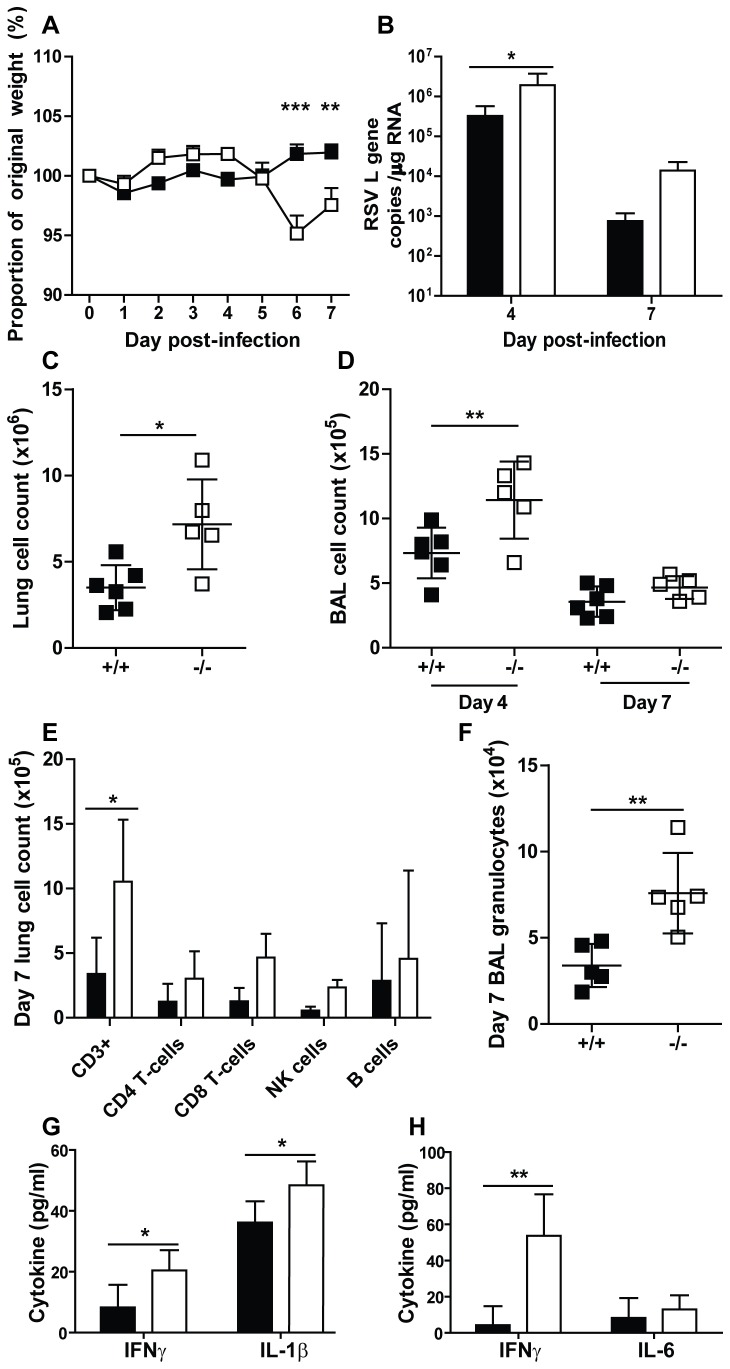
Comparison of RSV infection in Ifitm3-/- mice to wild type mice.Ifitm3-/- or wild type littermate control mice were infected i.n. with 5x105 RSV A2. Mice were weighed daily and weight changes recorded as a percentage of original weight (A). Lungs were excised and viral load calculated by qPCR on days 4 and 7 pi (B). Total cell counts from lung (C) and BAL (D) were calculated, along with totals of CD3, CD4 and CD8 (T cells), CD19 (B cells) and DX5+ (NK cells) (E) measured in lung by flow cytometry on day 7 post infection. Granulocyte numbers were also calculated in the BAL on day 7 post infection (F) Levels of the inflammatory cytokines IFNγ and IL-1β in lung (G) and IFNγ and IL-6 in BAL (H) were measured by ELISA on day 7 post infection. ■: wild type, □: Ifitm3-/-. Results show means ± S.D. (n > 5). Statistical significance was assessed by Student’s t-test, or ANOVA followed by Bonferroni's Multiple Comparison Test when there were more than two groups (* p<0.05, ** p<0.01, *** p<0.001).